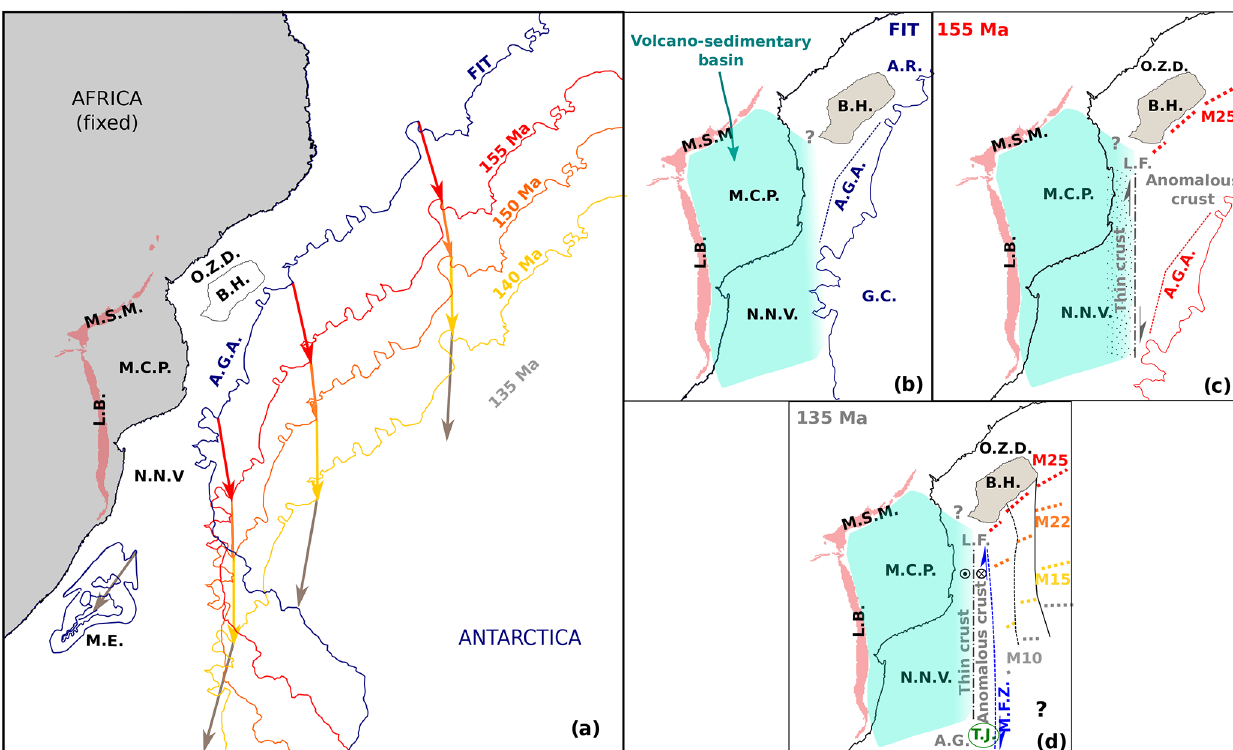
Figure 17. Evolution of the Limpopo margin (LM). (a) Kinematic of the Antarctica plate with respect to the African plate fixed according to (Thompson et al., 2019). (b, c, d) Zooms on the evolution of the LM with major features annotated before rifting (b) , at breakup (c) and after the opening of the Mozambique Basin along the LM (d) . Magnetic anomalies are from Mueller and Jokat (2019). LB stands for Lebombo monocline, MSM stands for Mateke Sabi Monocline, MCP stands for Mozambique Coastal Plain, NNV stands for North Natal Valley, ME stands for Maurice Ewing bank, BH stands for Beira high, OZD stands for Offshore Zambezi Depression, AGA stands for Antarctic Gravity Anomaly, GC stands for Grunehogna Craton, LF stands for Limpopo Fault, MFZ stands for Mozambique Fracture Zone, AG stands for Ariel Graben and TJ stands for Triple